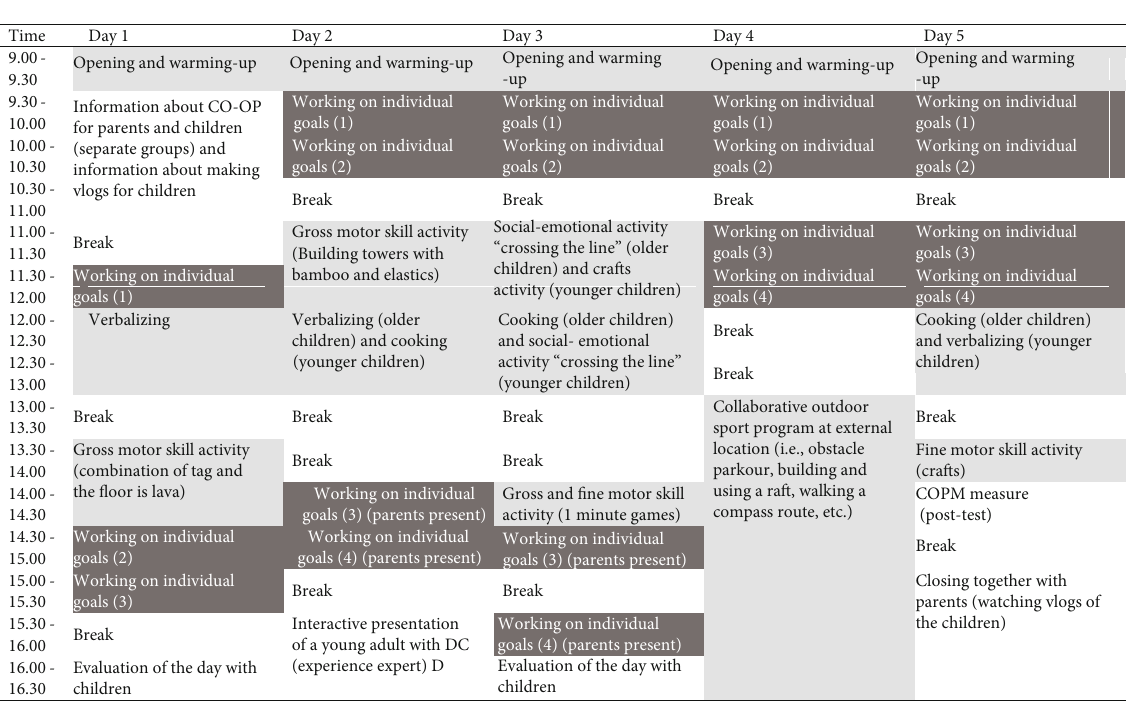
Figure 1: Time table of the intervention protocol with individual CO-OP sessions in dark grey, group activities in light grey, and other activities in white. Table 2: Overview of the types of intervention goals and transfer goals that were trained and the number of children that worked on a certain type of